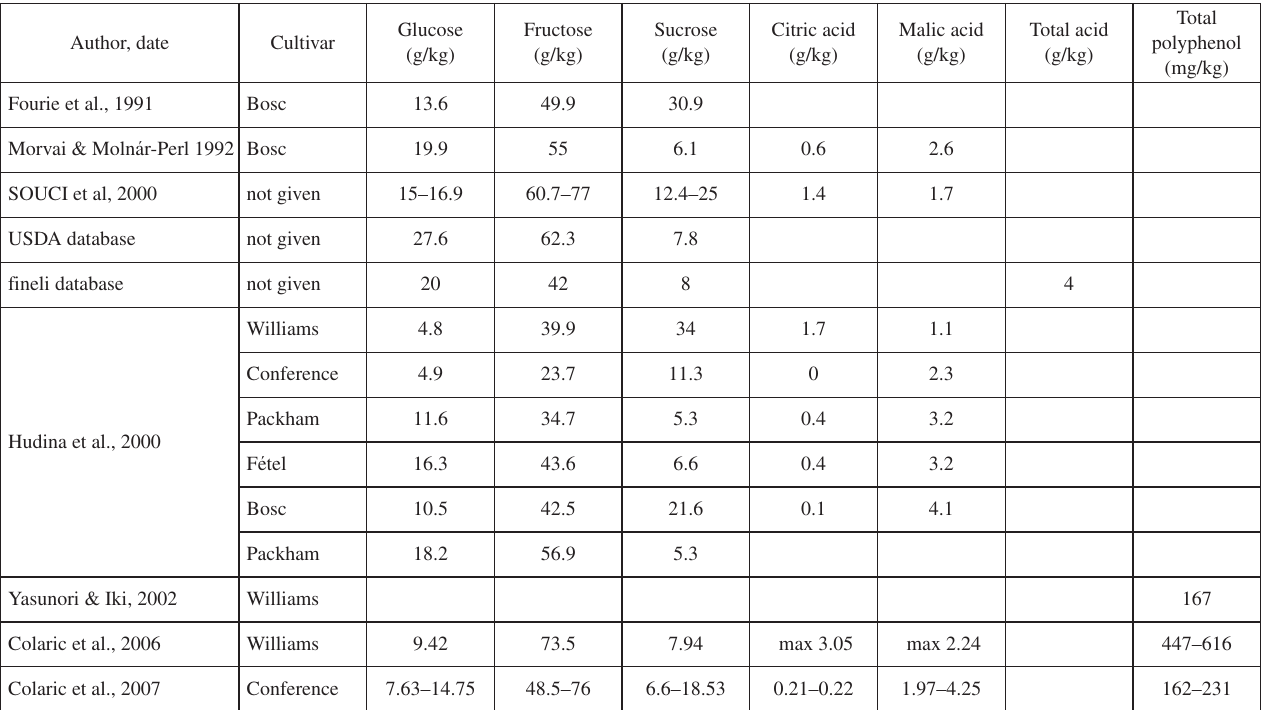
Table 1: Sugars, acids and polyphenols in